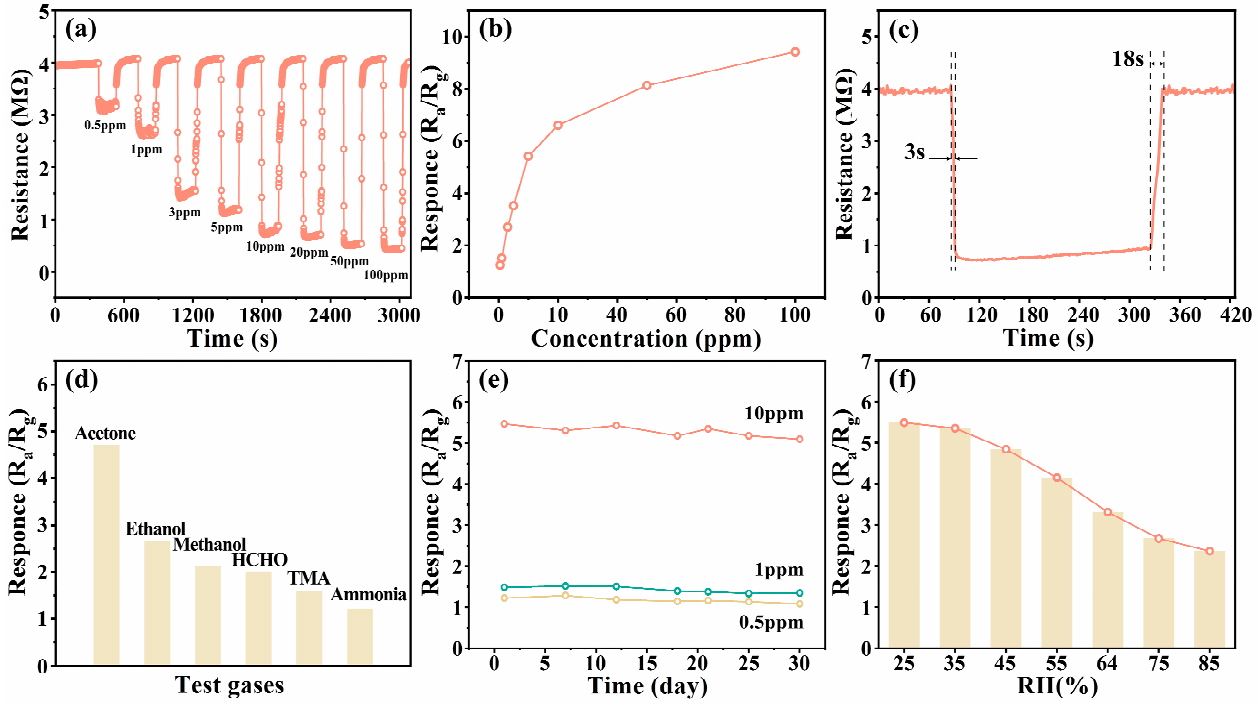
Figure 8. ( a ) The transient response and recovery curves for acetone in the range of 0.5–100 ppm. ( b ) The corresponding sensing response as a function of acetone concentration. ( c ) The dynamic sensing transients to 10 ppm acetone. ( d ) The selectivity and ( e ) long-term stability for 0.5/1/10 ppm acetone. Here, the sensor is made of 5-rGO/In 2 O 3 composites, and the operating temperature is 150 °C. ( f ) The sensing responses to 10 ppm acetone under different relative humidity levels at 150 °C.